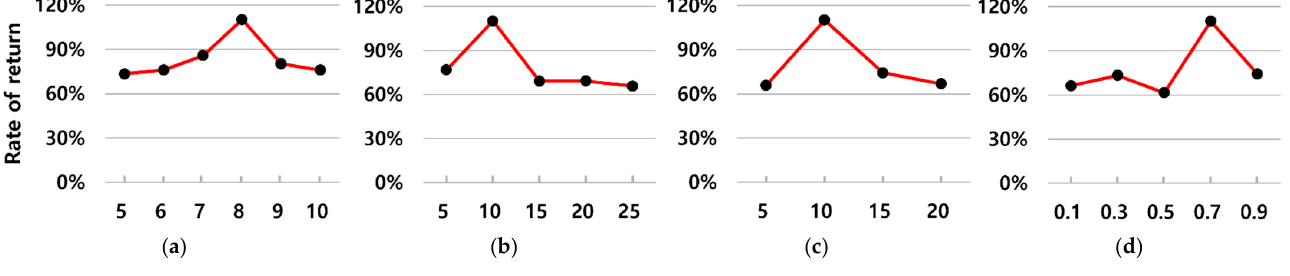
Figure 15. Comparison with other hyperparameter values. ( a ) Dimensionality. ( b ) Number of Clusters. ( c ) Sliding Window Size. ( d ) Noise Size.